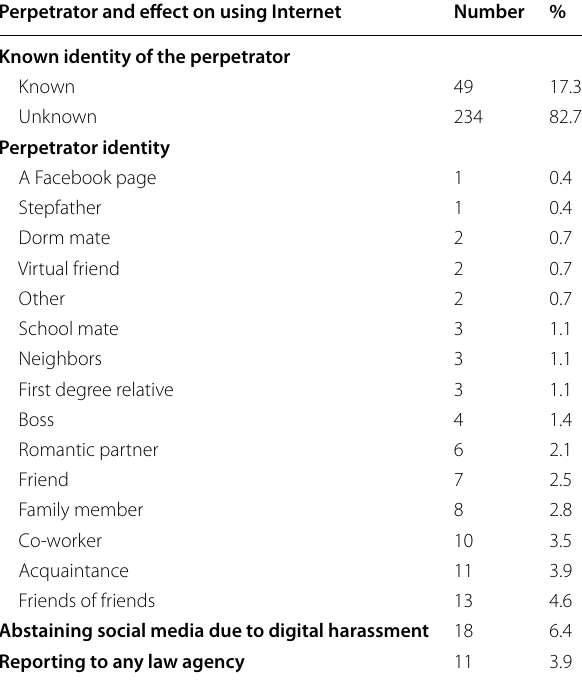
Table 6 Perpetrator and effect of digital harassment on using the Internet as reported by the harassed study participants ( n